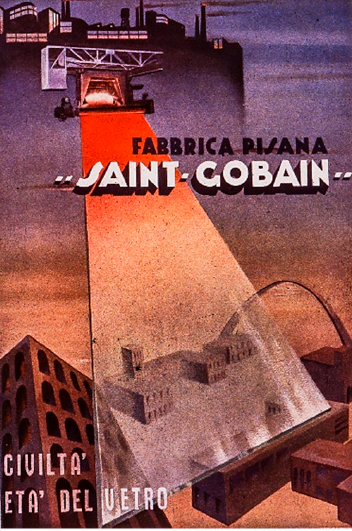
Figure 7. Advertising of Fabbrica Pisana St-Gobain. Image from Civiltà (1940).